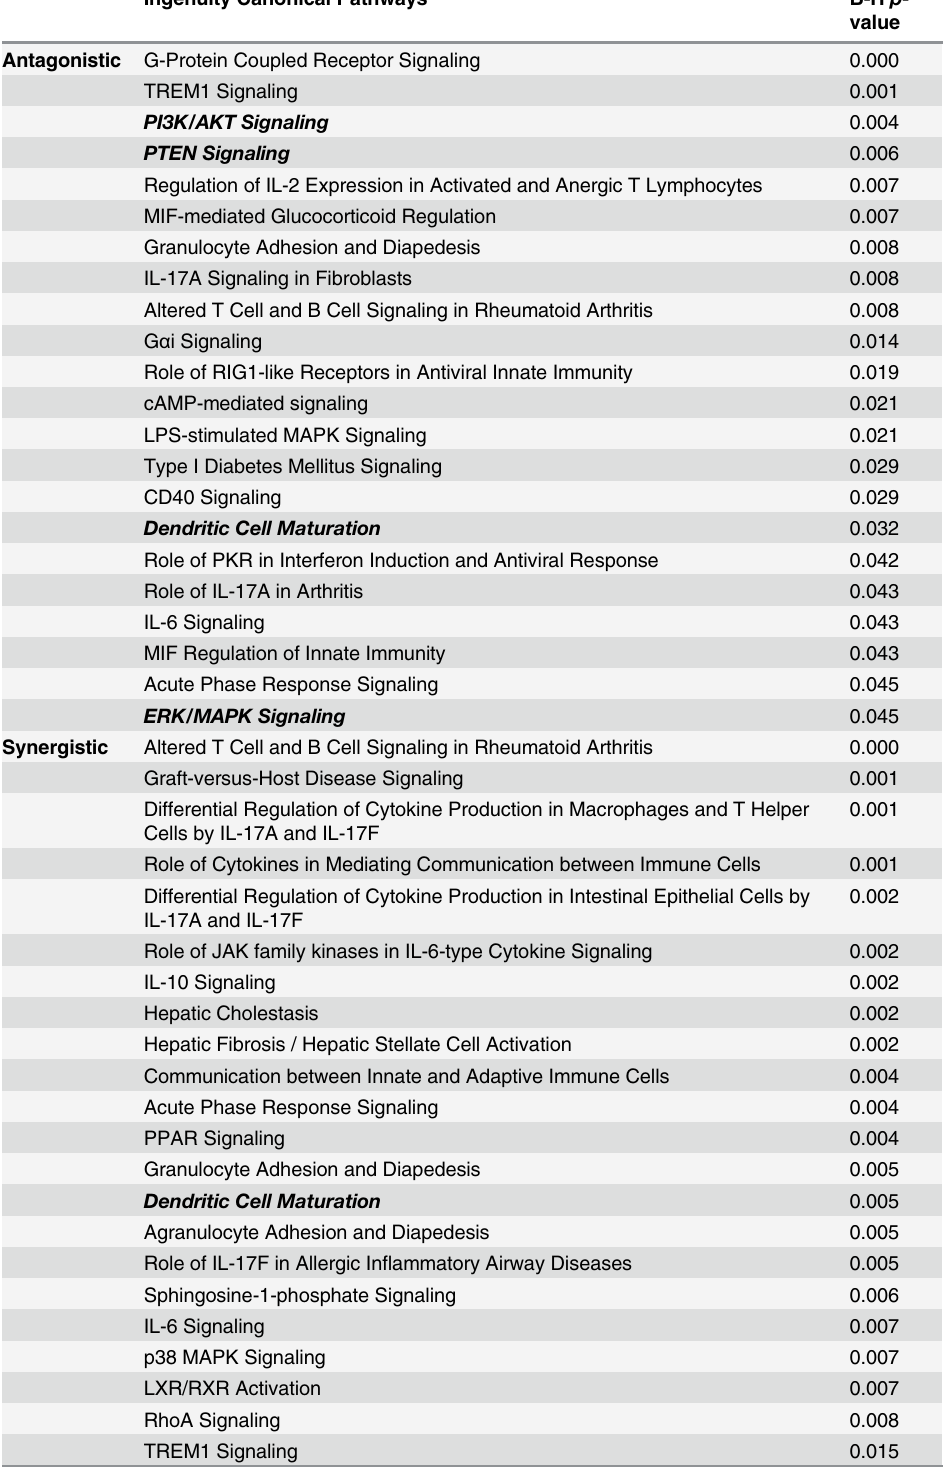
Table 6. Canonical pathways with Benjamini-Hochberg p -value < . 05 for probesets showing antago- nism or synergy in the 2×2 experimental setup with 100 μ g